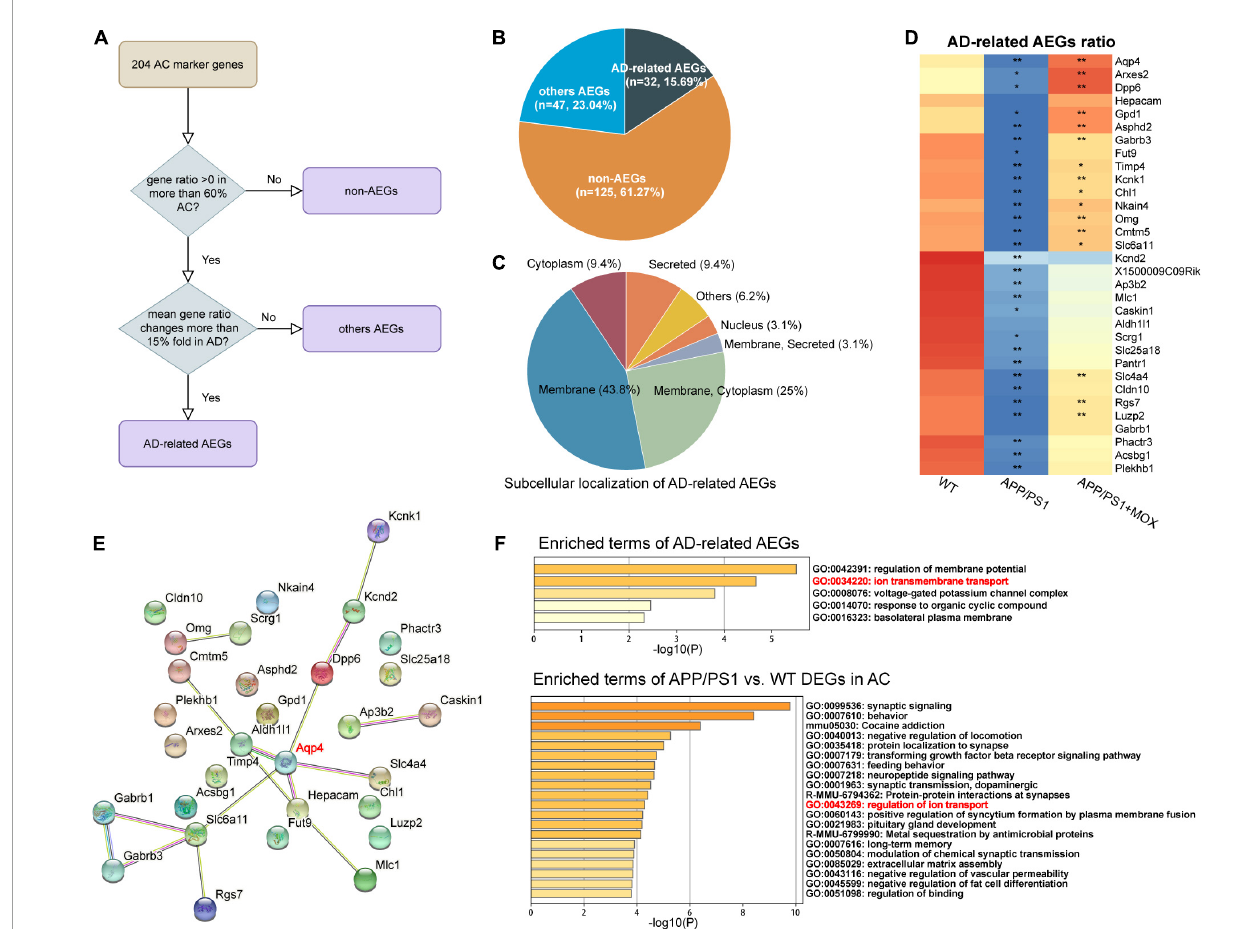
FIGURE5 Other astrocyte endfoot genes changed in perivascular AC. (A) Flowchart of astrocyte endfoot gene (AEG) screening. (B) Pie chart indicating the proportion of AD-related AEGs to total AC marker genes. (C) Classification of AD-related AEGs based on subcellular localization analysis. (D) Heatmap of AD-related AEG ratio. All AD-related AEG ratios have a larger reduction in the APP/PS1 group. One-way analysis of variance with post-test * P < 0.05, ** P < 0.01 APP/PS1 vs. WT and APP/PS1 + MOX vs. APP/PS1. (E) Protein–protein interaction (PPI) network constructed of AD-related AEGs using STRING. Among them, Aqp4 is located in the central position. (F) Pathway enrichment analysis of AD-related AEGs and AC-DEGs. Both of them enriched the pathway of ion transmembrane transport